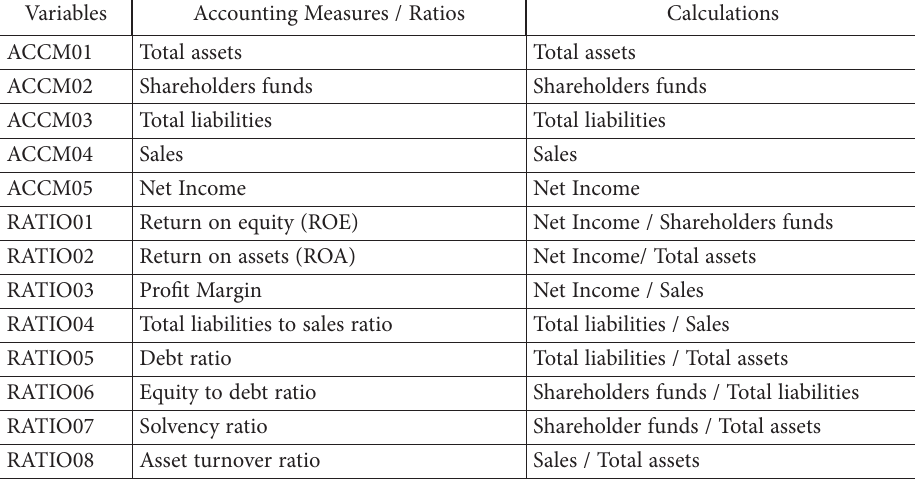
Table 3. Classification of accounting measures and ratios (quantitative